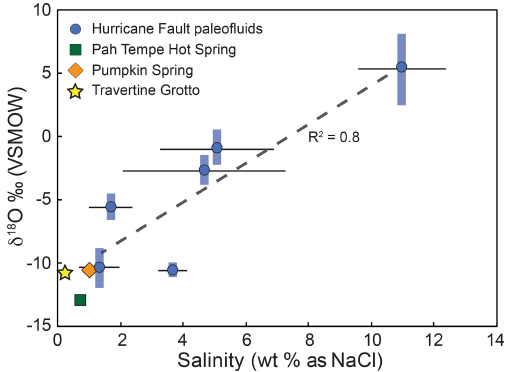
Figure 7. Calculated paleofluid oxygen isotope composition versus fluid salinity determined by fluid inclusion microthermometry. The strong positive correlation of δ 18 O and salinity ( R 2 = 0 . 8) is inter- preted as a mixing trend between the low-salinity, meteoric water and the high-salinity sedimentary brine end-member. For compari- son, the composition of Pah Tempe, Pumpkin, and Travertine Grotto springs are included and are very similar in composition to the low- salinity